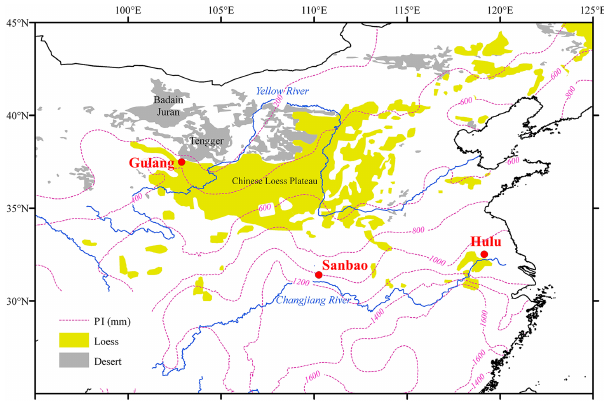
Figure 1. Map showing the loess distribution and locations of the Gulang loess section, Sanbao, and Hulu caves. Dotted lines indicate the precipitation isohyets